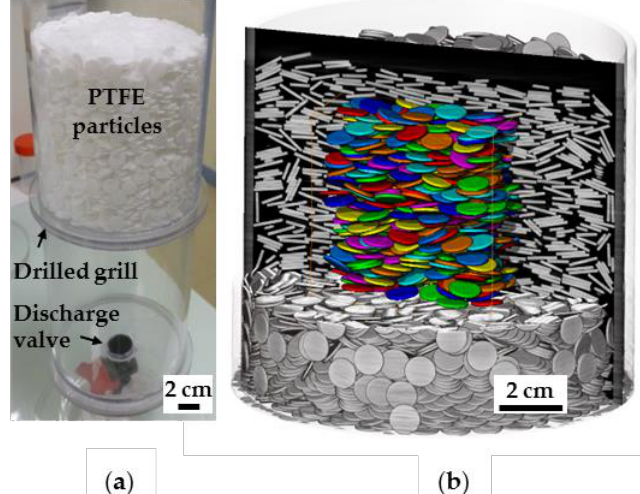
Figure 2. Experimental setup for packing of polytetrafluoroethylene (PTFE) disks. ( a ) Cylindrical column for sedimentation of 10,000 disks in different fluids. Disks are settled in the volume located above a flat drilled grill while evacuation of fluids is achieved through a discharge valve located at the bottom of the column; ( b ) X-ray microtomography analysis and extraction of individual particle orientation in a sub-volume of the experimental packing.